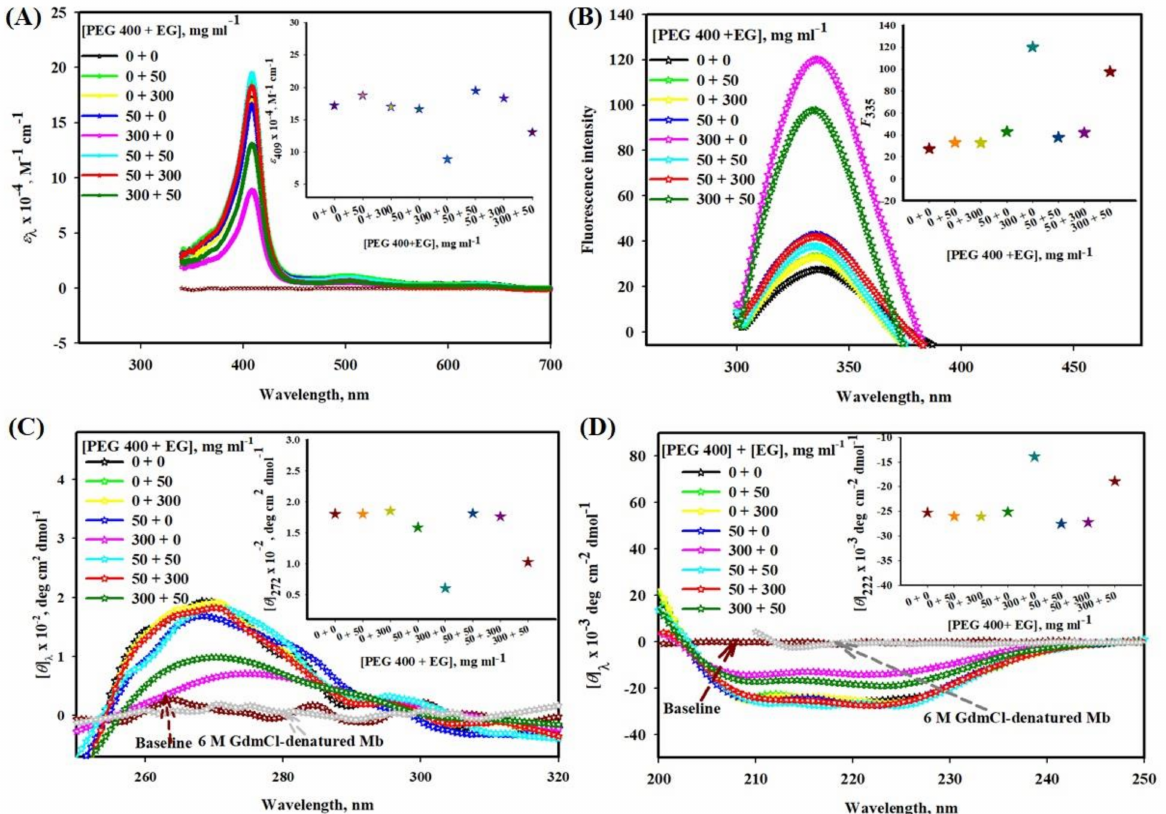
Figure 1. ( A ) Absorption, ( B ) tryptophan fluorescence, ( C ) near-UV CD and ( D ) far-UV CD spectra of Mb with different concentration mixtures of PEG 400 and EG. Insets of ( A ), ( B ), ( C ) and ( D ) displays a plot of ε 409 , F 335 , [ θ ] 272 and [ θ ] 222 versus various [PEG 400 + EG], where different color stars depicts different [PEG 400 + EG]. All experiments were made at pH 7.0 and 25 ◦